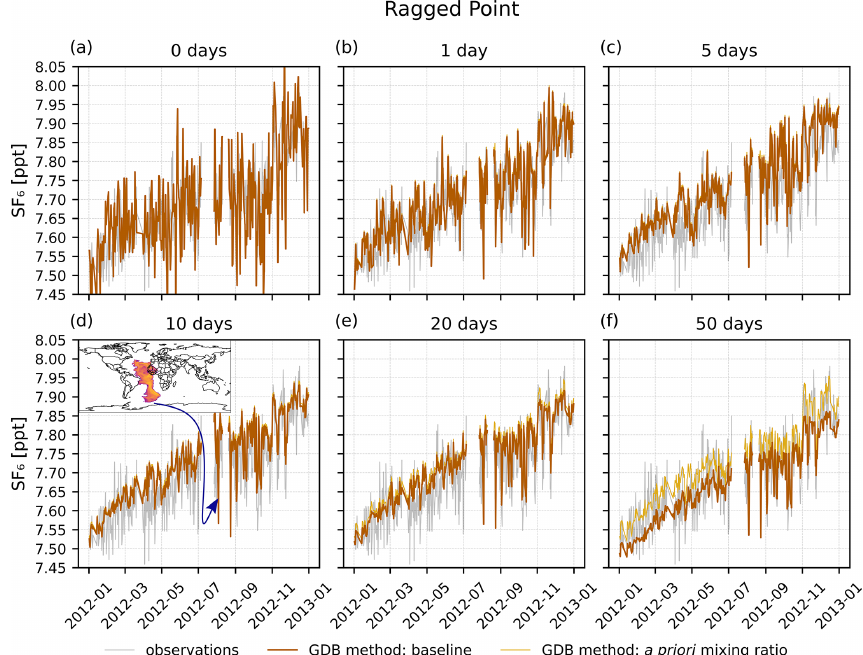
Figure 7. Baseline and a priori SF 6 mixing ratios calculated with the GDB method at the Ragged Point measurement station for backward simulation periods of 0 ( panel a) , 1 (b) , 5 (c) , 10 (d) , 20 (e) , and 50d (f) . The inset in panel (d) shows the termination sensitivity averaged over all heights for the time of the marked observation low point, illustrating the method’s ability to account for baseline changes due to episodic transport from the Southern